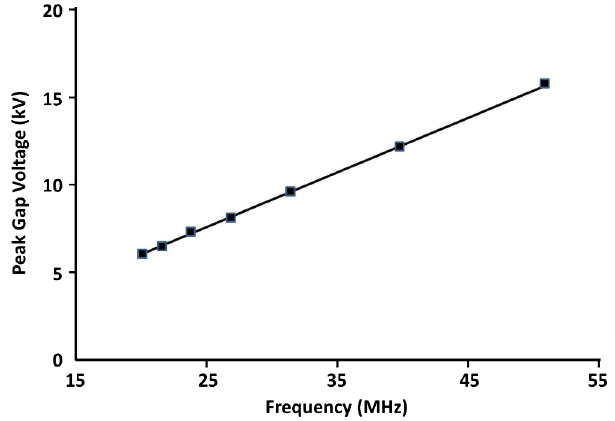
FIG. 28. Measured frequency dependence of Q value of 4E2 under biased condition.